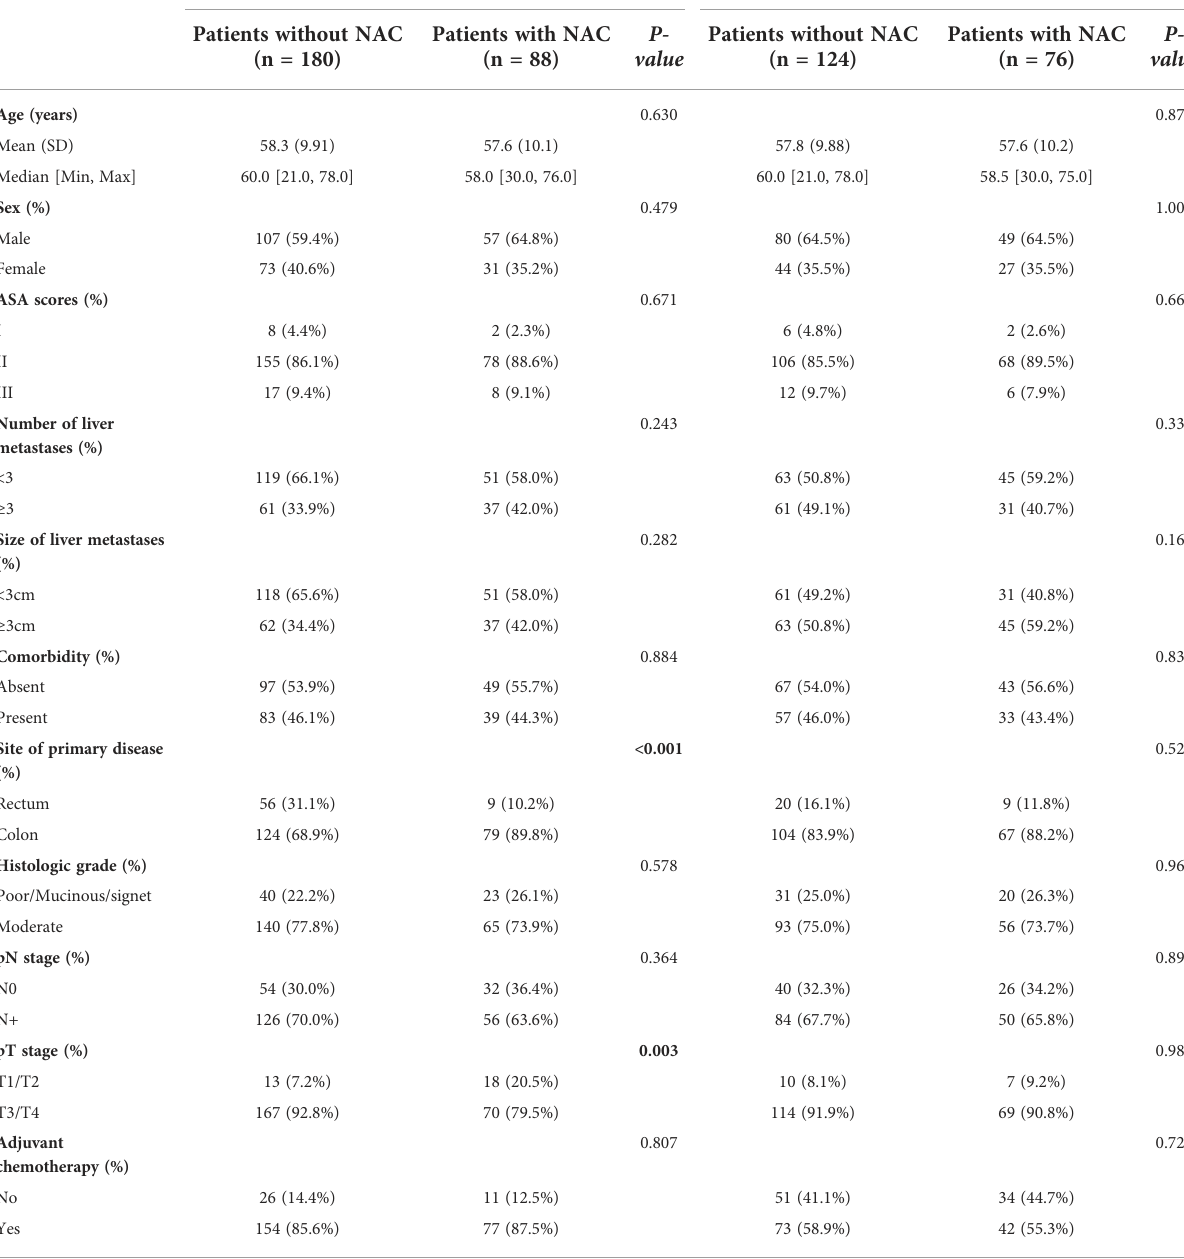
TABLE 1 Baseline clinical characteristics of NCC